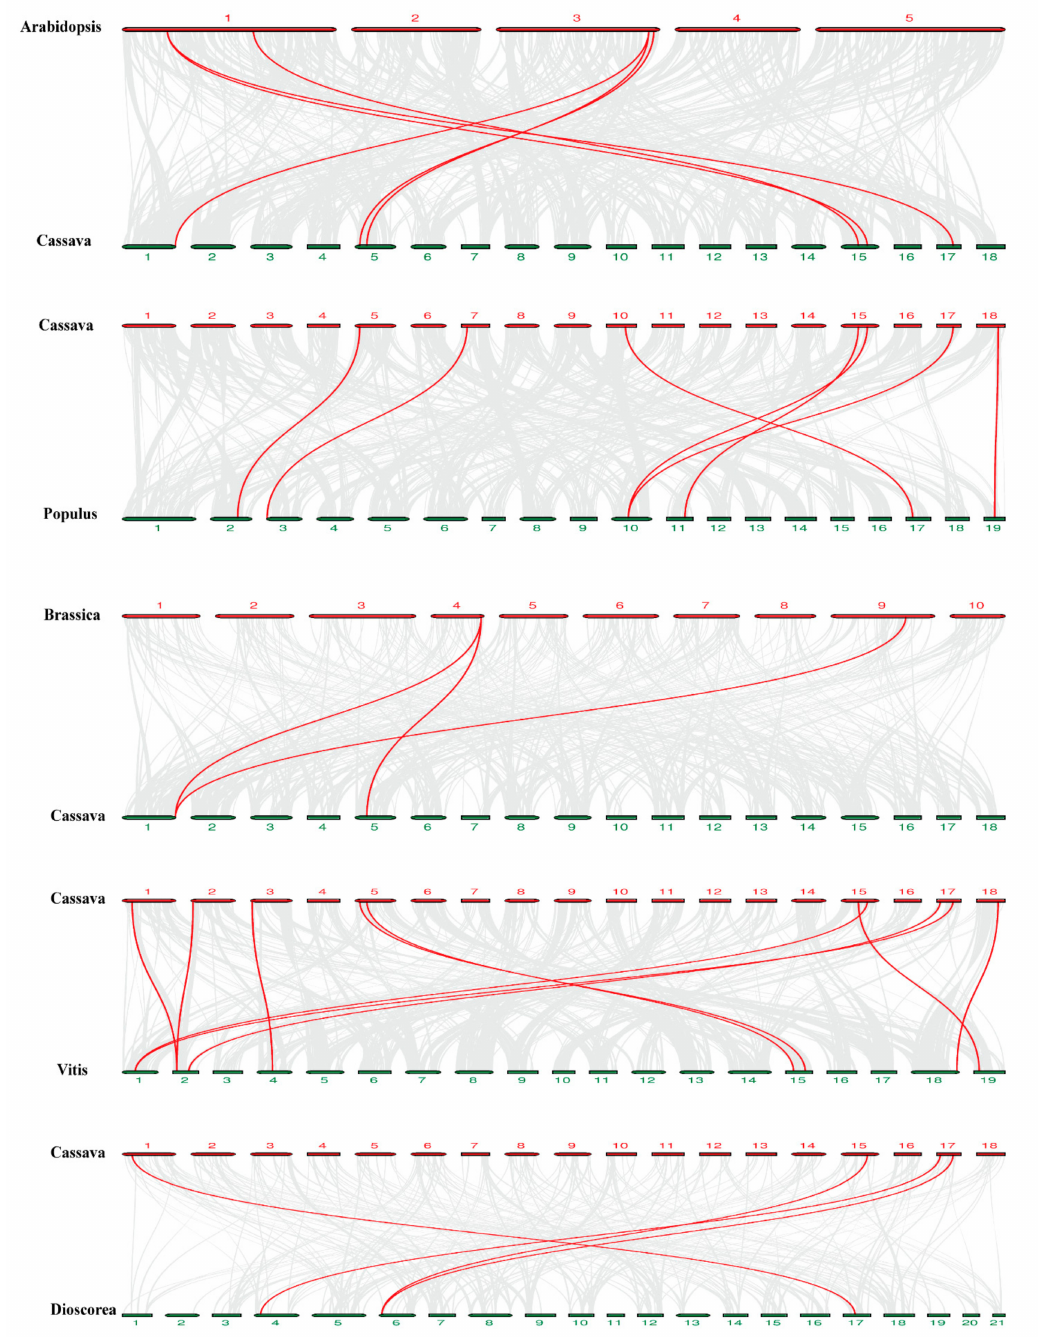
Figure 5. Synteny analysis of Dynamin genes between cassava and five representative plant species. Gray lines in the background indicate the collinear blocks within cassava and other plant genomes, while the red lines highlight the syntenic Dynamin gene